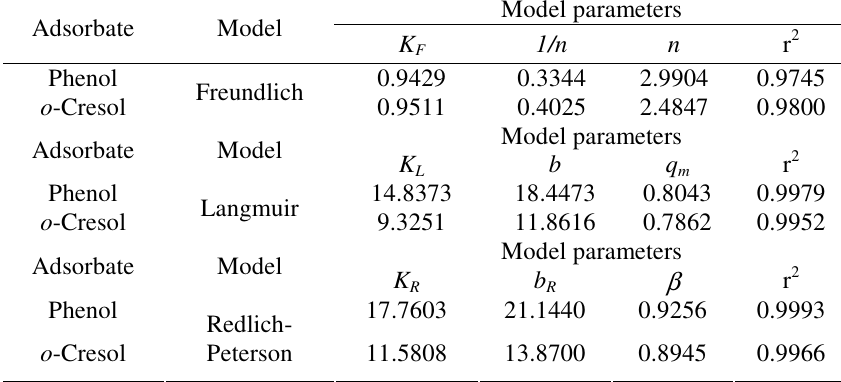
Table 7. Isotherm parameters for adsorption of phenols on CC at 60 °